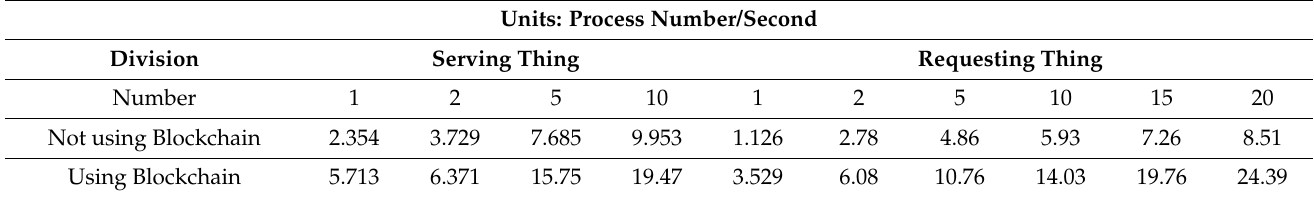
Table 3. Evaluation of IoT data processing time using Raspberry Pi 3. Units: Process